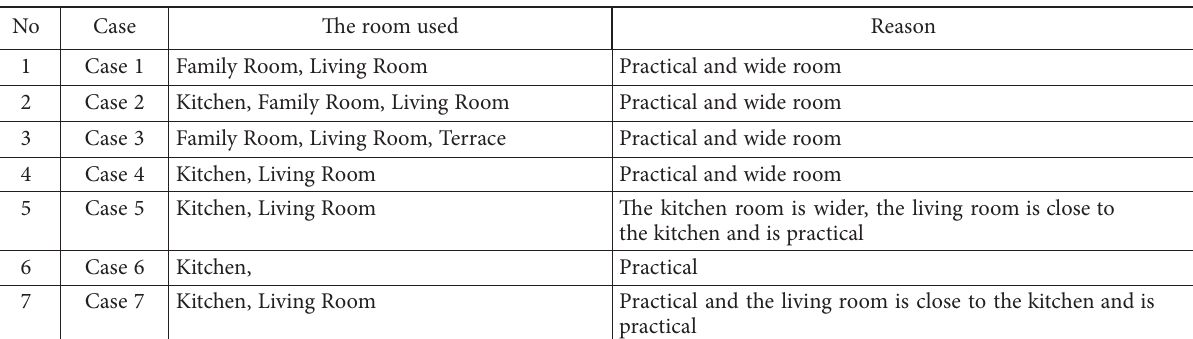
Table 1. Use of mixed use